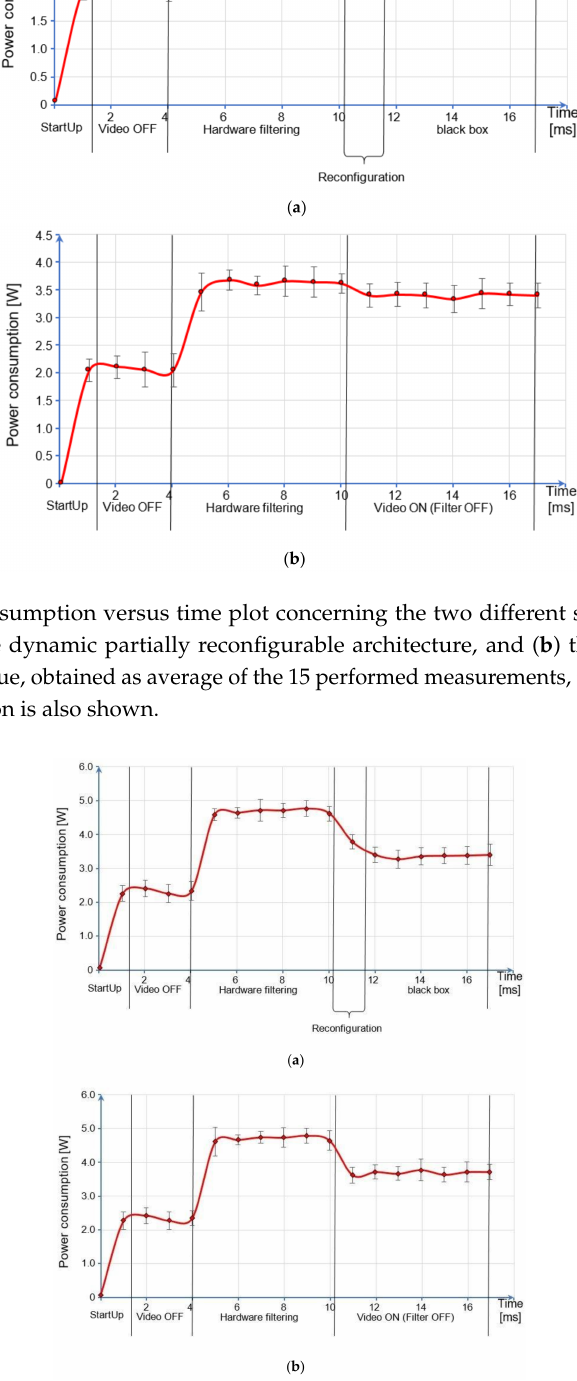
Figure 9. Power consumption versus time plot concerning the two different systems for the FAST filtering DSP: ( a ) the dynamic partially reconfigurable architecture, and ( b ) the static architecture. For each reported value, obtained as average of the 15 performed measurements, the error bar denoting the standard deviation is also